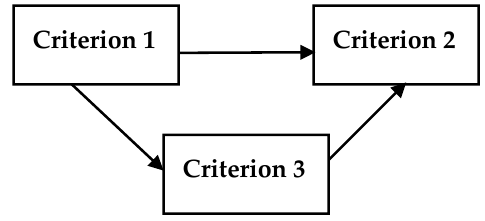
Figure 3. Impact-relation map for the criteria of maternal and child health.